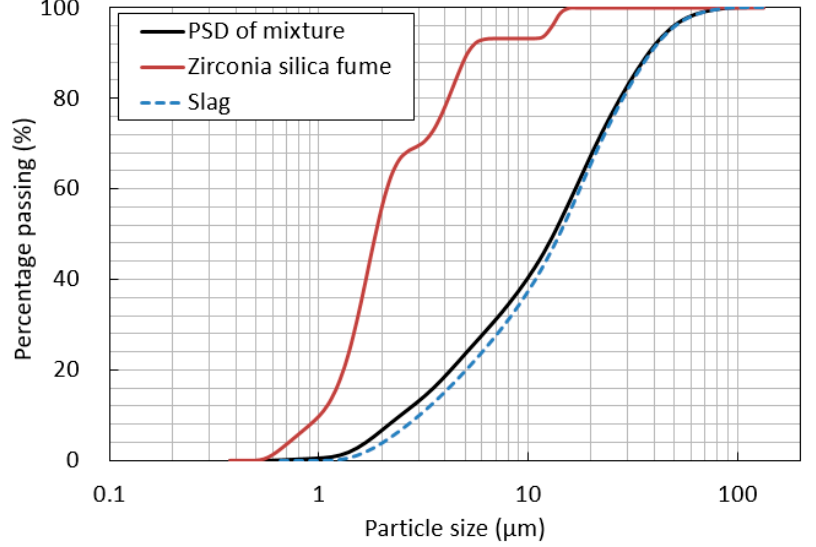
Figure 1. Particle size distribution.